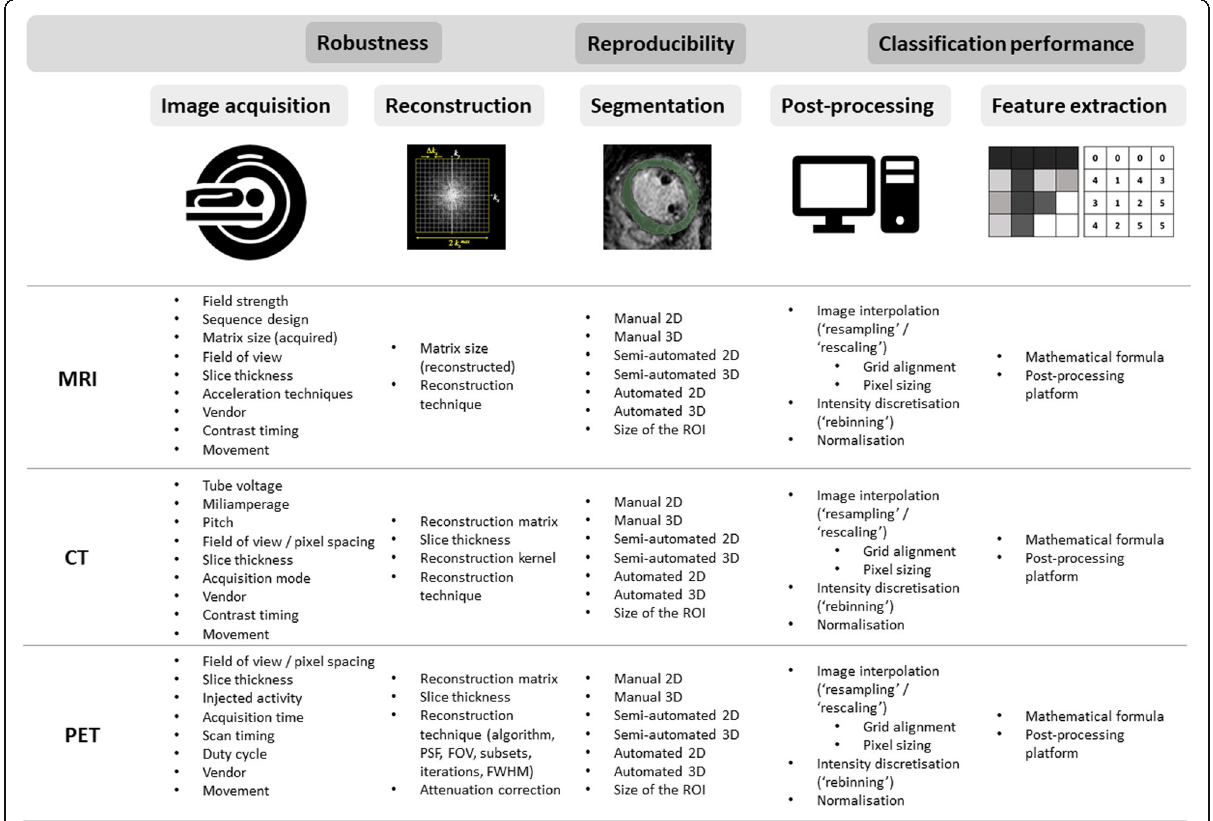
Fig. 4 Factors influencing radiomics stability. Summary of technical factors in each step of the radiomics workflow potentially decreasing radiomic feature robustness, reproducibility, and classification